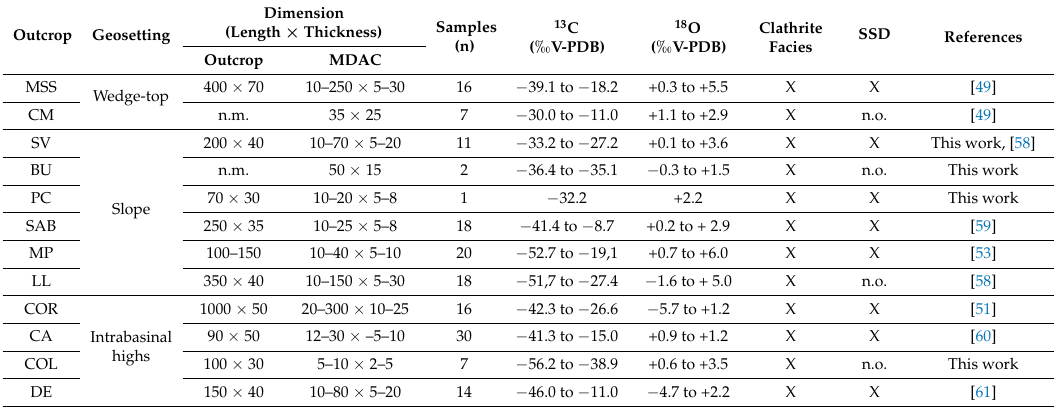
Table 1. Field and geochemical data of the examined seep-carbonate